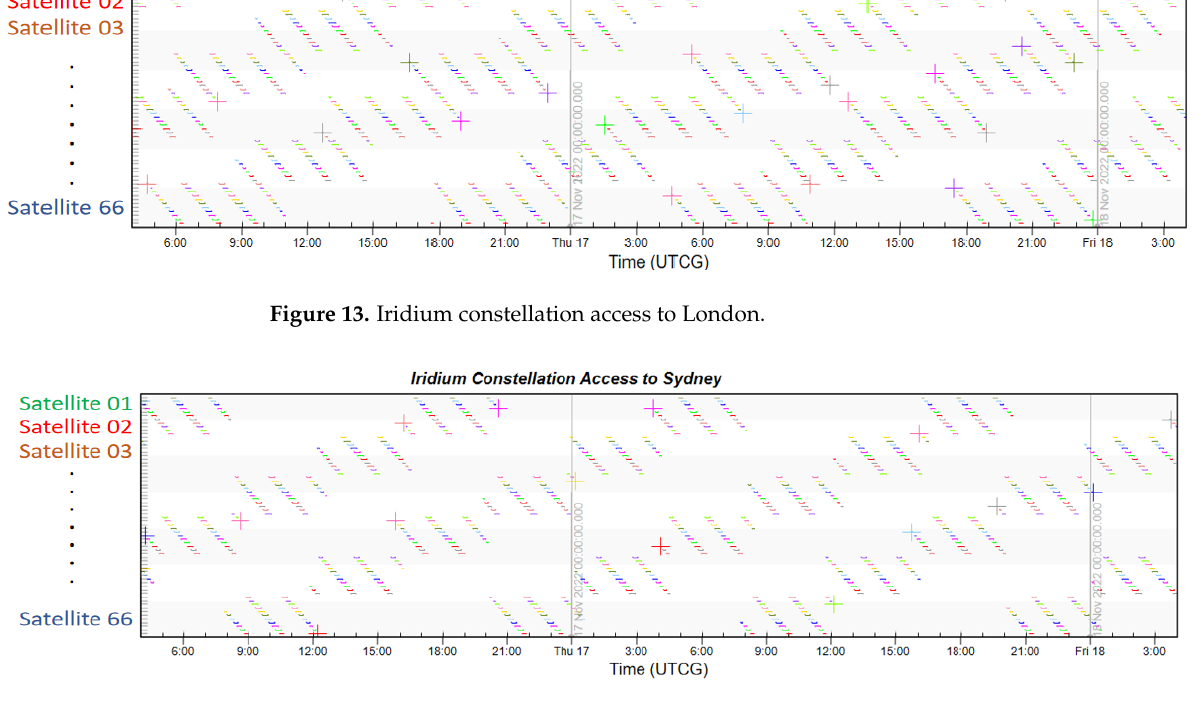
Table 5. Initial orbit elements of two